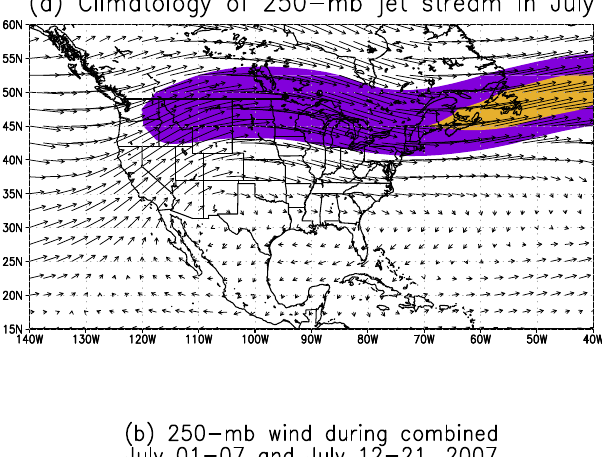
Figure 3a. As for the specific jet stream of July 2007, it is manifested as an intensified ridge to the west and deepened trough to the east, in comparison to the climatological July jet stream. In particular, the days during 1–7 July and 12–21 July of 2007 are defined as the sub-period by visual inspection of daily weather maps. These days during this sub-period all feature the similar jet stream structure as shown in Figure 8b.